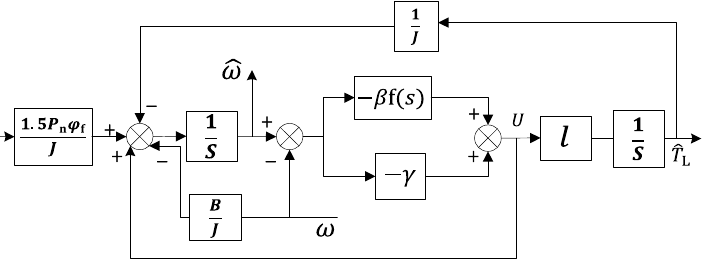
Figure 3. Structure diagram of the symmetric S-type function disturbance observer (SSFDO).